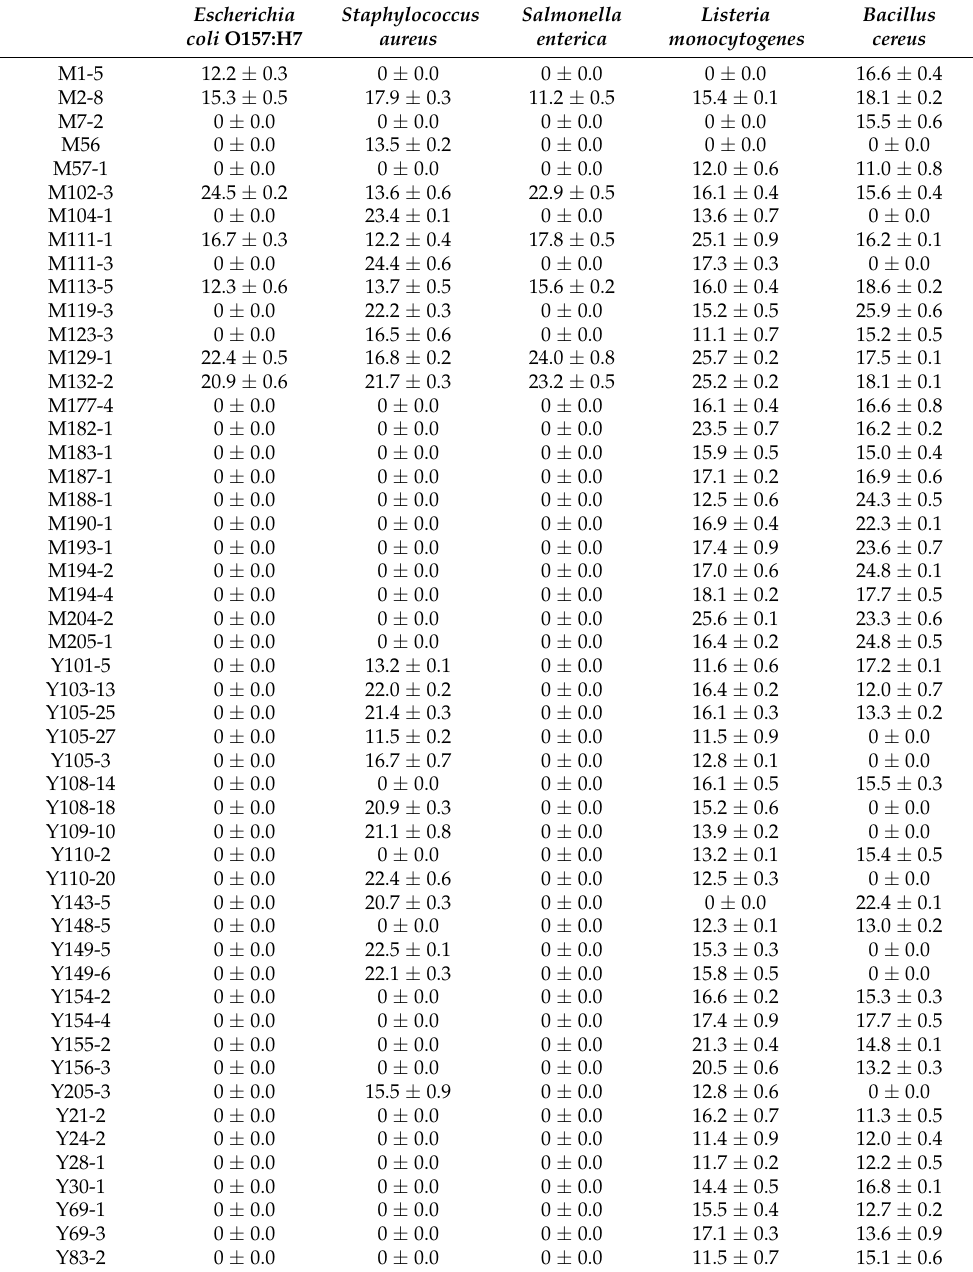
Table 1. Inhibitory spectrum of LAB isolates from fermented